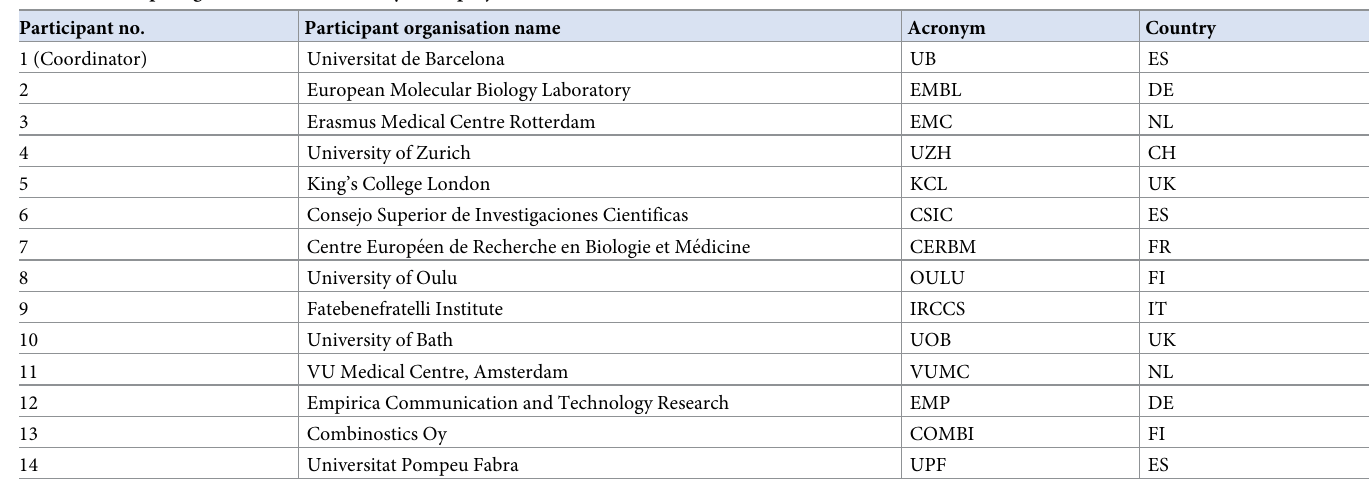
Table 1. Participating institutions in the EarlyCause project. Participant